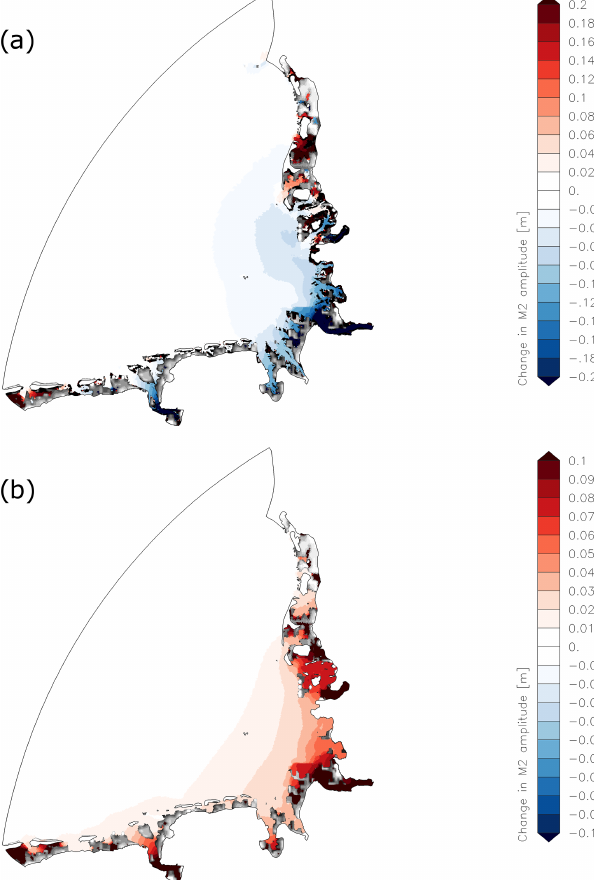
Figure 7. (a) Changes in M2 amplitude due to the removed estuaries (increase in red, decrease in blue, dry areas in grey) (GBM_ref_NE – GBM_ref_noQ). (b) Changes in M2 amplitude due to MSLR 0.8m in the German Bight Model without the estuaries (increase in red, decrease in blue) (GBM_80_NE – GBM_ref_NE).